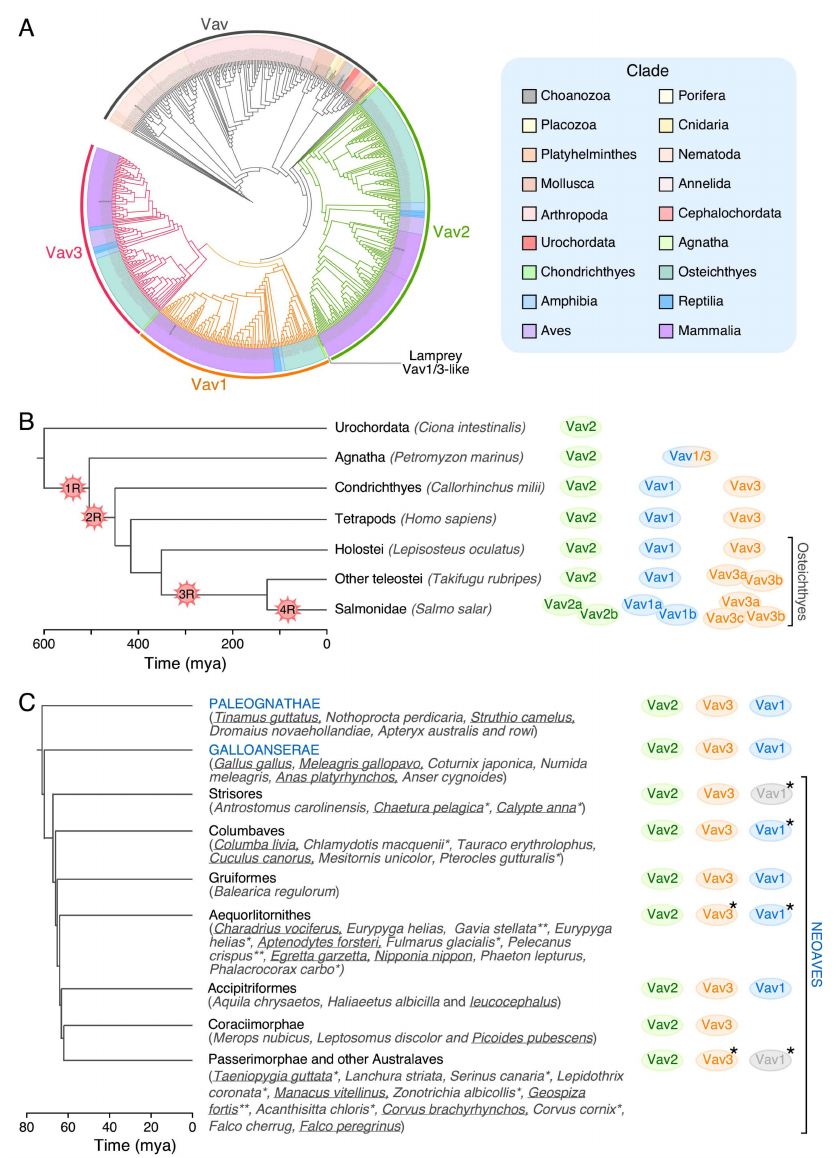
Figure 5. The gain and loss of Vav family members in vertebrates. ( A ) Phylogenetic tree of Vav family proteins (left). Proteins containing DH and SH2 domains were obtained from the UniProt database and the phylogenetic tree reconstructed using the maximum-likelihood method. Node colors indicate if the protein belongs to the single Vav family group (gray color) or the vertebrate Vav1 (orange color), Vav2 (green color) or Vav3 (purple color) branch. The lamprey ( Petromyzon marinus ) Vav1 / 3-like protein node has been highlighted in light brown. The color code used for each phylogenetic clade is shown on the light blue box (right). ( B ) Number of Vav family genes conserved in each vertebrate clade. 1R and 2R indicate the two rounds of whole-genome duplications that took place before the divergence of jawless and cartilaginous fish, respectively. 3R and 4R indicate the lineage-specific whole-genome duplication events associated with the origin of the ancestor of most teleost fish and salmonids, respectively. Time scale is indicated at the bottom (Mya; million years ago). ( C ) Variability in the number of Vav family proteins in avian clades. Species with either high-coverage or fully sequenced genomes are underlined. Cases associated with the loss of Vav1 and / or Vav3 genes in some species are indicated with asterisks. Proteins colored in gray indicate that the Vav family member has been lost in a high percentage of species of the indicated group. Avian phylogeny has been established as described elsewhere [105]. Time scale is indicated at the